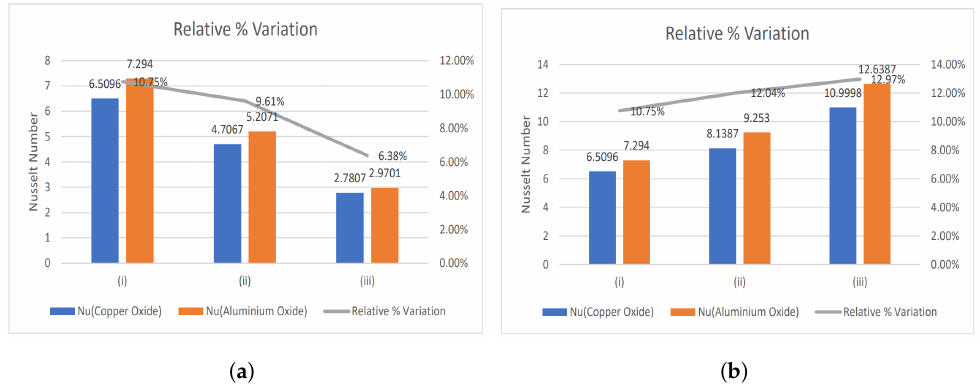
Figure 4. Relative % variation for ( a ) Eckert number (i) Ec = 0.2, (ii) Ec = 0.4, (iii) Ec = 0.6, and